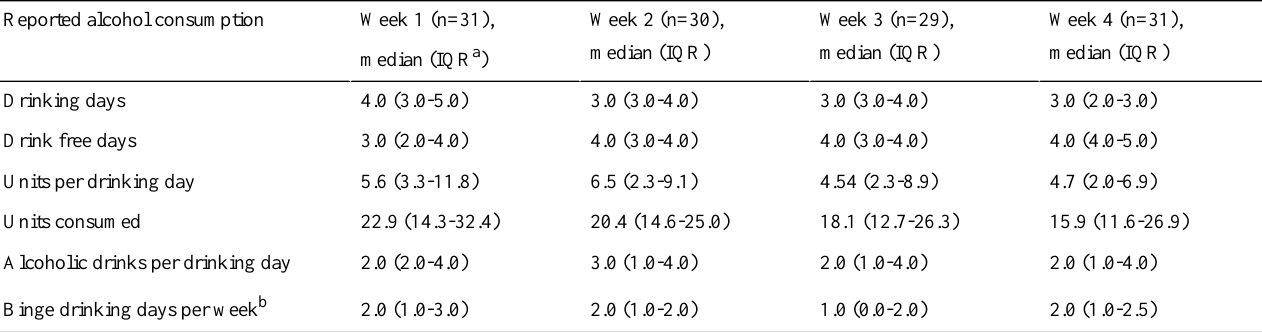
Table 5. Drinking behavior of participants over the study period; n denotes number of participants who recorded an alcohol event during the period.